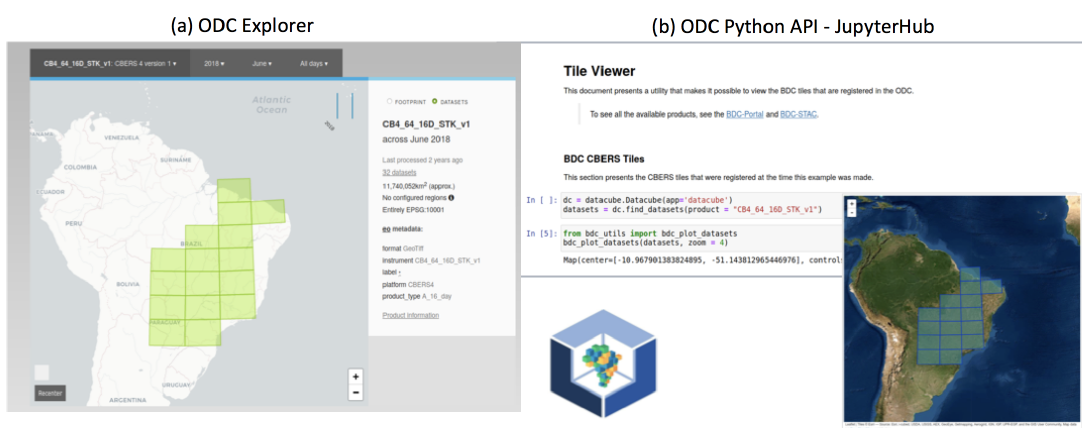
Figure 7. BDC Web portal available at: http://brazildatacube.dpi.inpe.br/portal/explore.